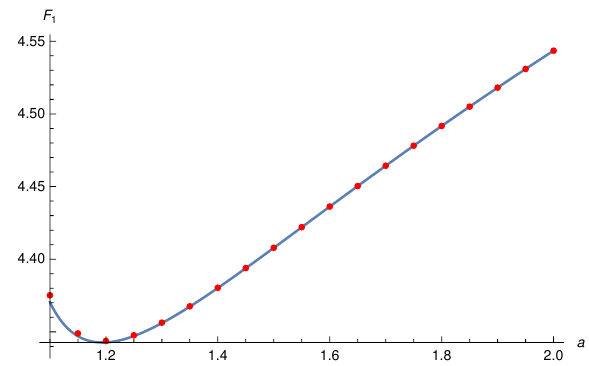
Figure 15. Plot of the genus-one free energy F 1 ( a ) in the decon(cid:12)ned phase a > 1. The red dots are the numerical value of log Z ( N; a ) (cid:0) N 2 F 0 ( a ) for N = 30, while the solid curve is the plot of the analytic form of F 1 ( a ) in